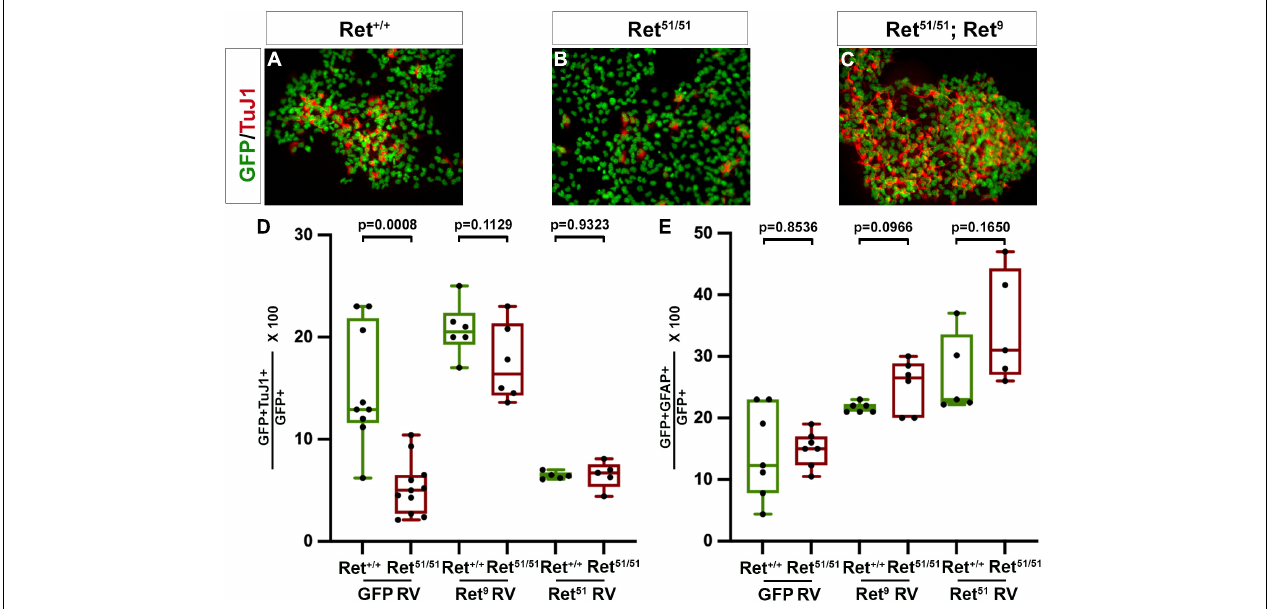
FIGURE 6 | Ret activity is critical for neuronal differentiation of multilineage ENS progenitors. (A,B) Colonies established from control ( Ret + / + ) and Ret 51 / 51 EPCs were immunostained for GFP (green) and TuJ1 (red). Neuronal differentiation was dramatically reduced in the Ret 51 / 51 colony. (C) Expression of Ret 9 isoform in colonies from Ret 51 / 51 EPCs rescues their neuronal differentiation deficit. Graph (D) shows quantification of neuronal differentiation in control ( Ret + / + ) and Ret 51 / 51 EPC colonies after transduction with control GFP, Ret 9 and Ret 51 retroviruses (GFP RV, Ret 9 RV and Ret 51 RV). (E) Quantification of glial differentiation in control ( Ret + / + ) and Ret 51 / 51 EPC colonies after transduction with control GFP, Ret 9 and Ret 51 retroviruses (GFP RV, Ret 9 RV and Ret 51 RV). Neuronal differentiation was rescued on expressing the Ret 9 isoform but this was reduced when Ret 51 isoform was expressed in control ( Ret + / + ) EPCs. EPCs were isolated from 3 independent Litters. genotypes were pooled and 6–11 colonies counted post transduction, FACS and culture. Statistical analysis performed by Welch’s t -test. ANOVA (and multiple comparison) analysis of equivalent colonies transduced with either control GFP, Ret 9 or Ret 51 retroviruses in shown in Supplementary Table 1